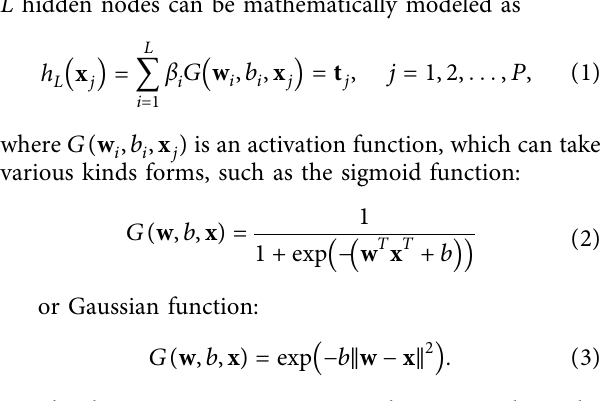
algorithm. The hybrid algorithm of Extreme